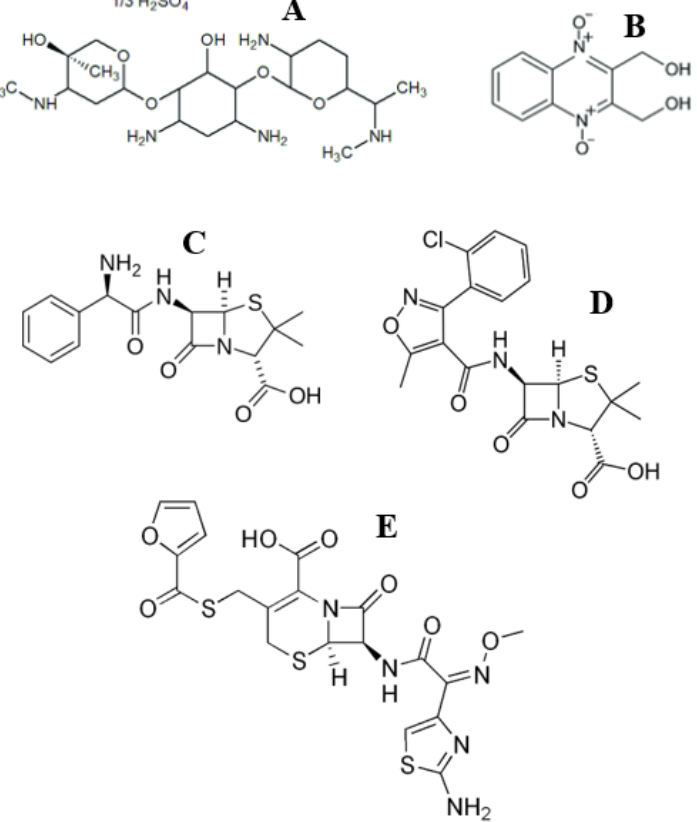
Figure 5. Chemical structures of antibiotic drugs used in the present work: Dienomast TM : gentamicin ( A ) and dioxidine sulfate ( B ) and in the previous works [9,10]: Lactobay TM : ampicillin ( C ) and cloxacillin ( D ) and Spectromast TM LC: ceftiofur ( E ).